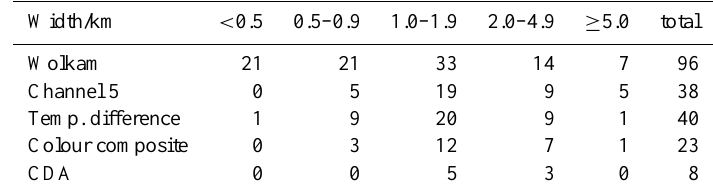
Table 3. Comparison of contrail detection in Wolkam and NOAA/AVHRR data as a function of contrail width. Width/km < 0.5